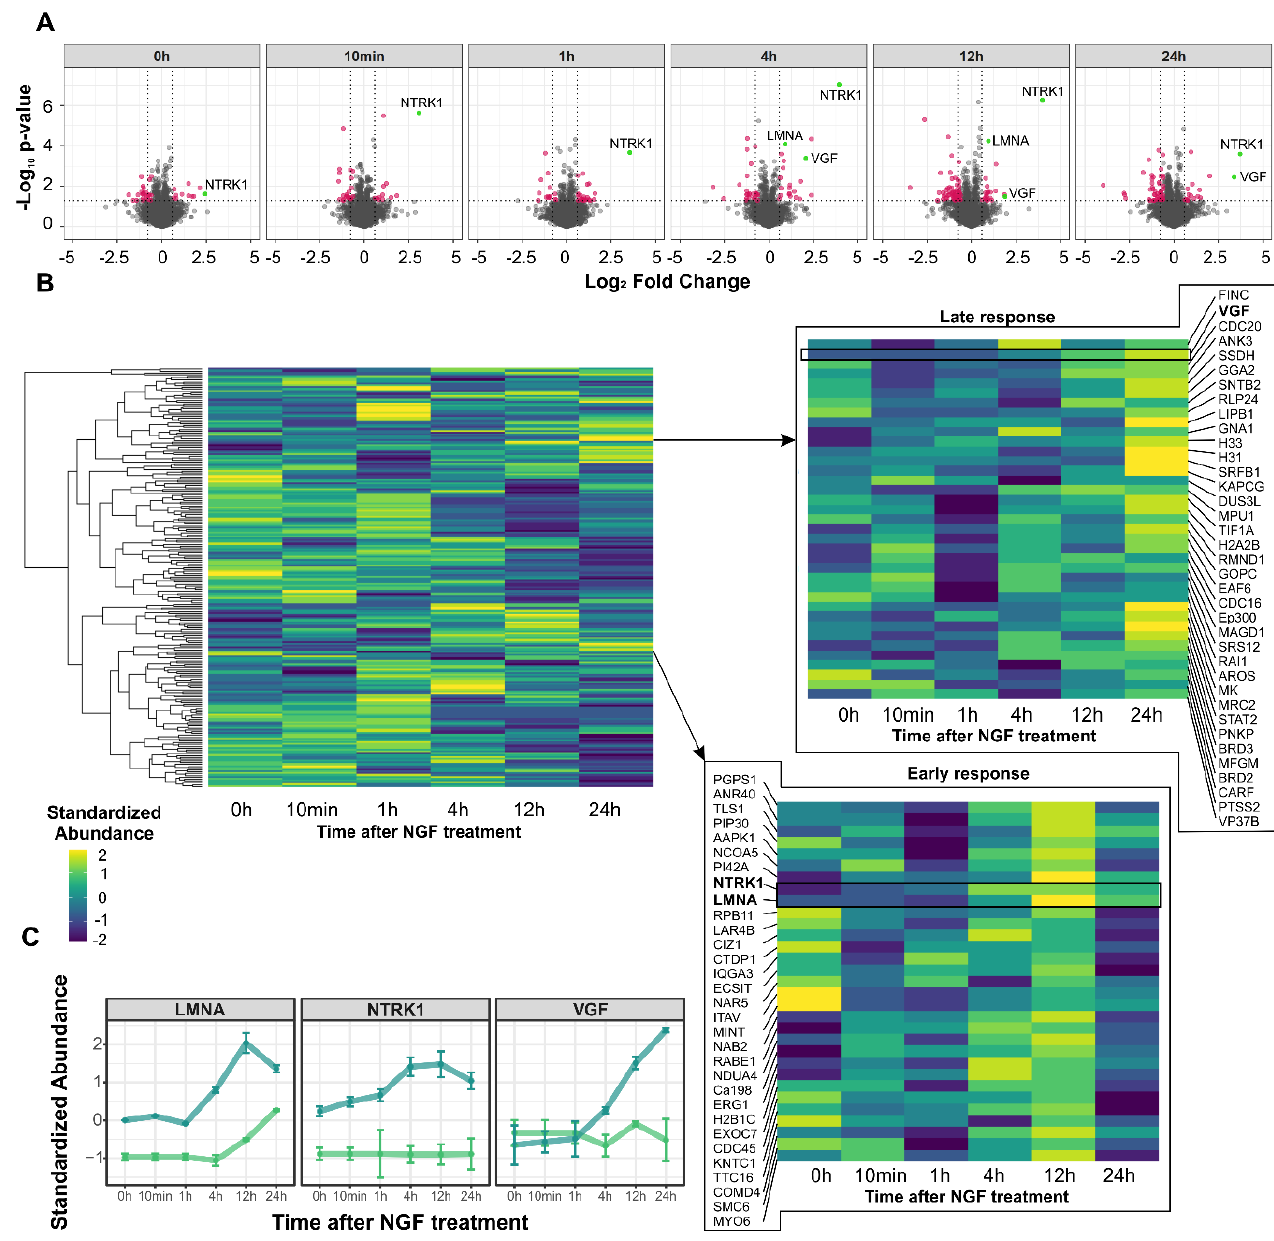
Figure 3. Proteome dynamics induced by NGF − mediated NTRK1 activation in IMR5 cells. ( A ) Volcano plots illustrating the differential expression of proteins for the time points indicated. Significantly differentially abundant proteins highlighted in red ( p -value ≤ 0.05; FC ≤ − 1.5 or ≥ 1.5), selected proteins highlighted in green. ( B ) Heatmaps representing hierarchical cluster analysis (Pearson correlation, complete linkage) of significantly regulated proteins. Magnifications show clusters of proteins with late and early increasing abundance, respectively. ( C ) Regulation profiles of selected protein candidates in NGF-treated cells (blue) compared to untreated controls (green).